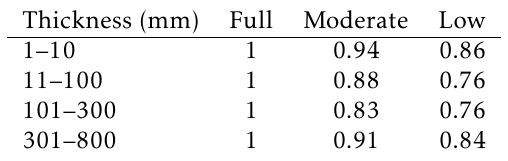
Figure 4: Fragility functions for large, high intensity, non- dairy pastoral farms at full temporal/seasonal vulner- ability, moderate temporal/seasonal vulnerability, and low temporal/seasonal vulnerability. See Table 7 for cal- culated values. Calculated temporality/seasonality coeffi- cients values for fragility functions for large, high in- tensity, non-dairy pastoral farms, created by subtracting line segments shown in Figure